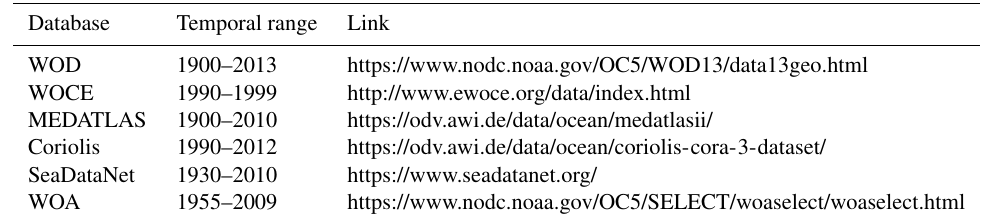
Table 1. Details of the different databases used in the analysis. Database